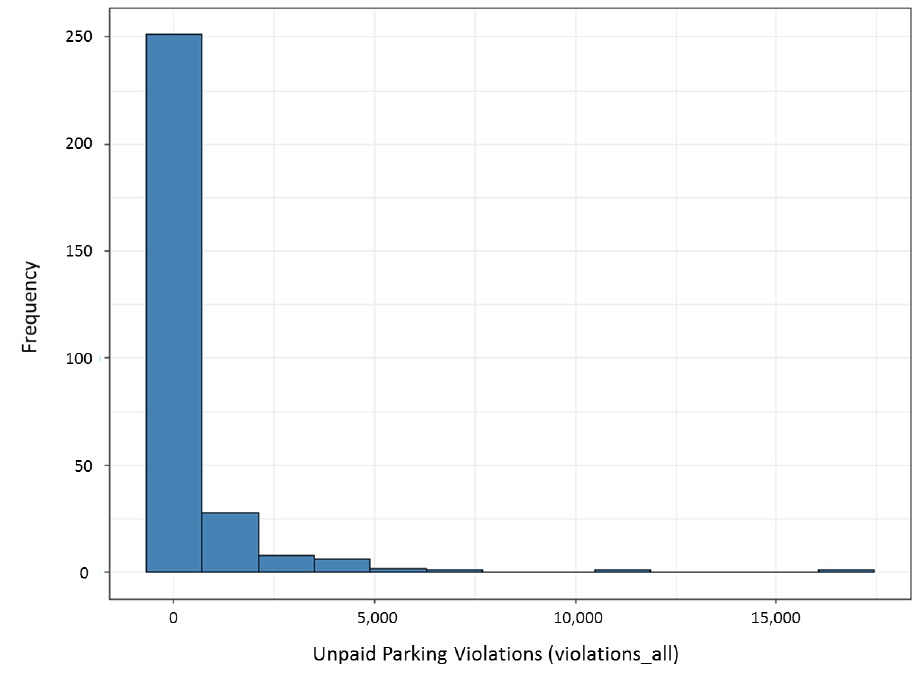
Figure 2. Histogram of the outcome variable ( violations_all ).